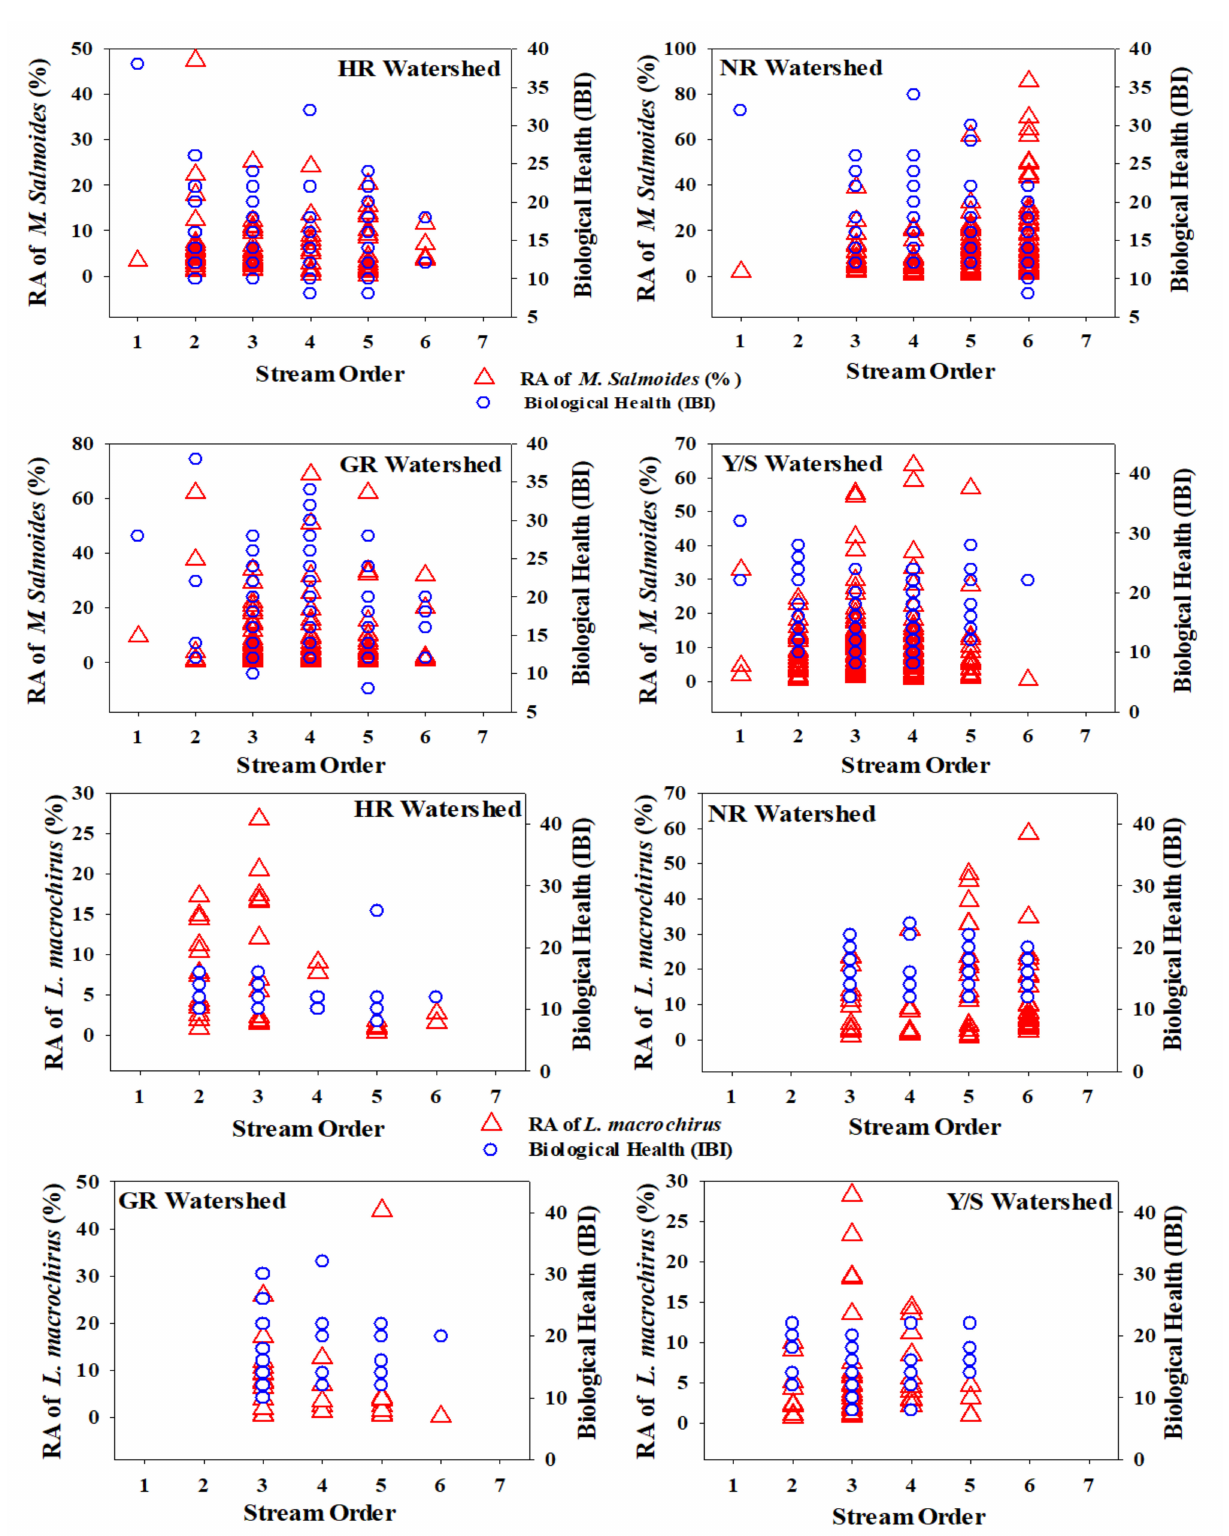
Figure 6. Invasive fish species interactions with trophic and tolerance guilds in the four major rivers during 2008–2009. HR = Han River, NR = Nakdong River, GR = Geum River, Y/SR = Yeongsan/Seomjin